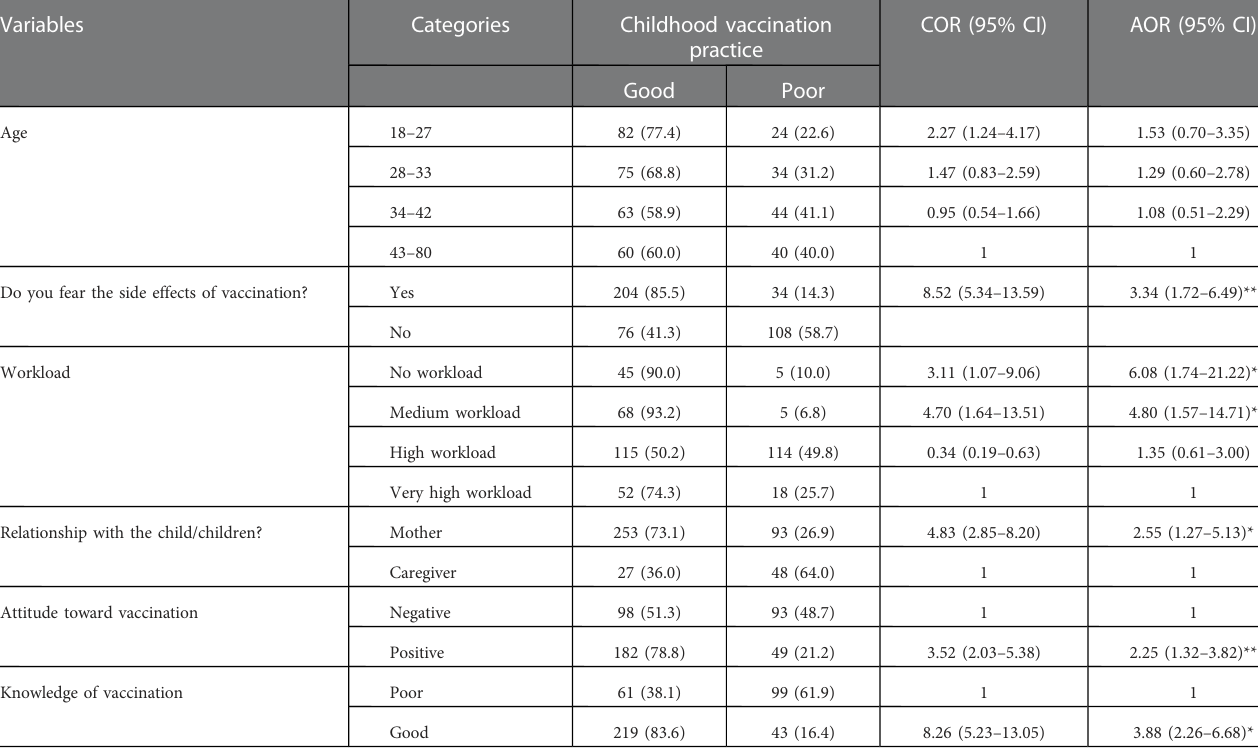
Variables Categories Childhood vaccination